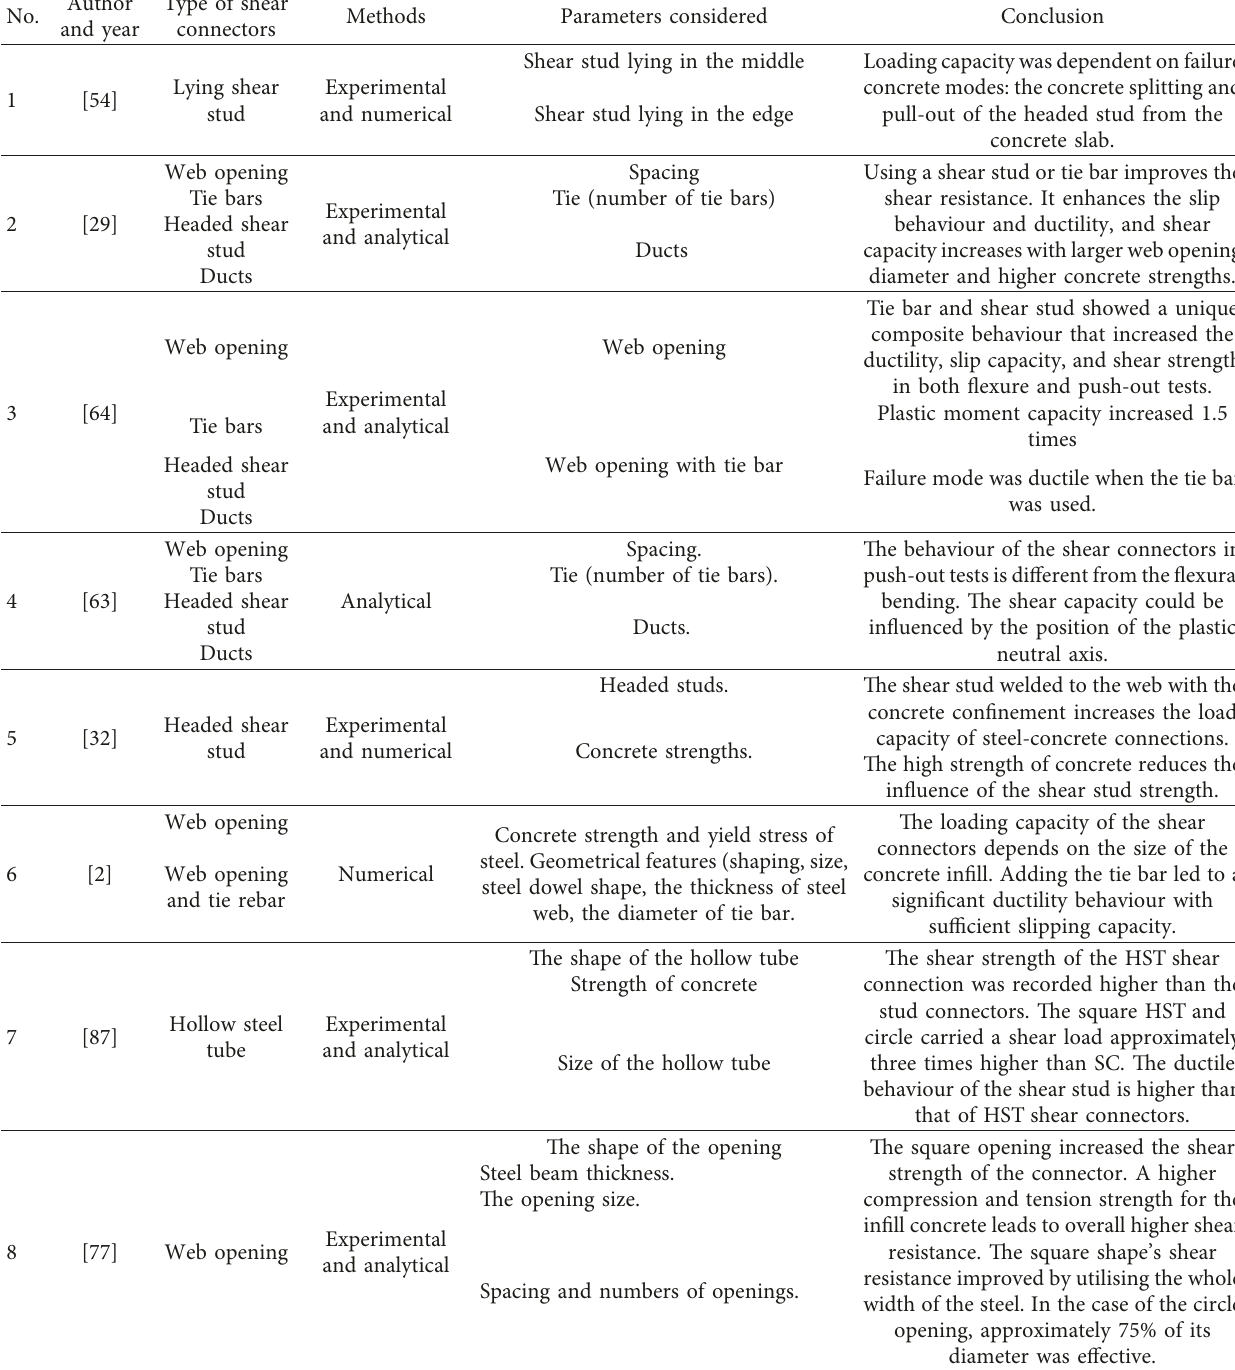
Table 2: Summary of studies on shear connectors in slim floor construction conducted using push-out